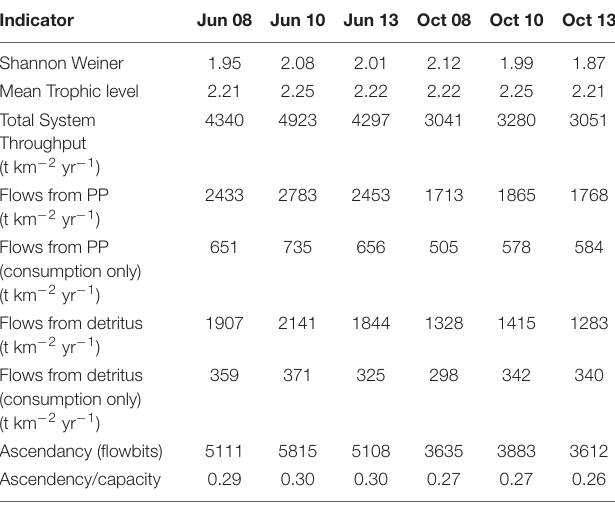
TABLE 3 | Indicator values from the Ecopath food web snapshots taken from the calibration simulation of Ecosim.